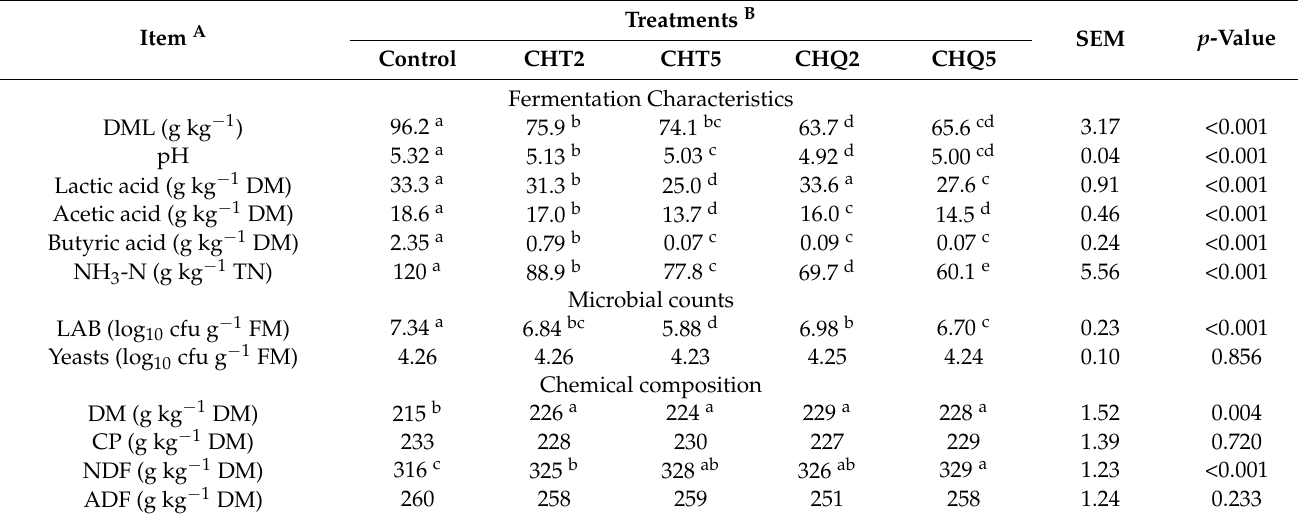
Table 2. Fermentation characteristics, microbial counts, and chemical composition of alfalfa silage treated without or with tannin additives.